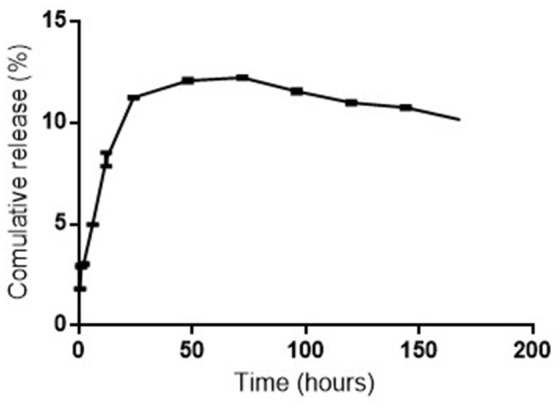
Cumulative in vitro release of curcumin and artesunate from CA-PLGA nanoparticle.